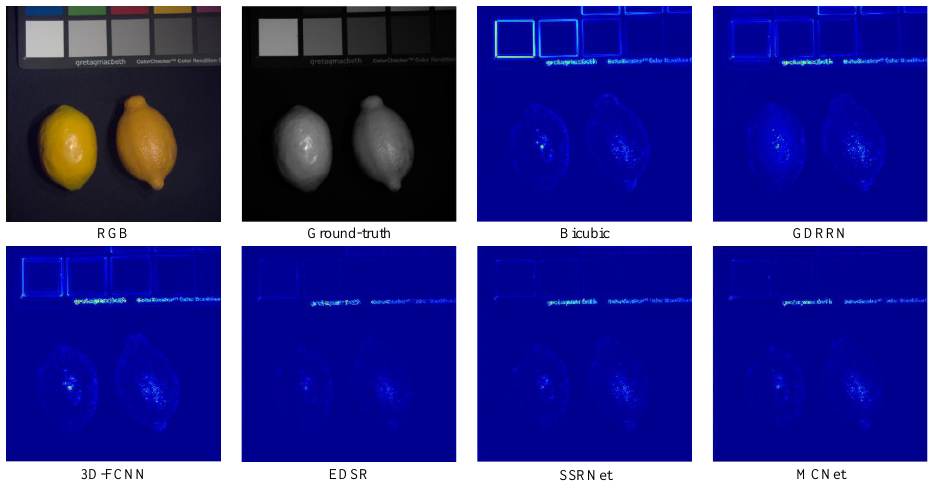
Figure 7. Absolute error map comparisons for image fake_and_real_lemons on CAVE dataset.